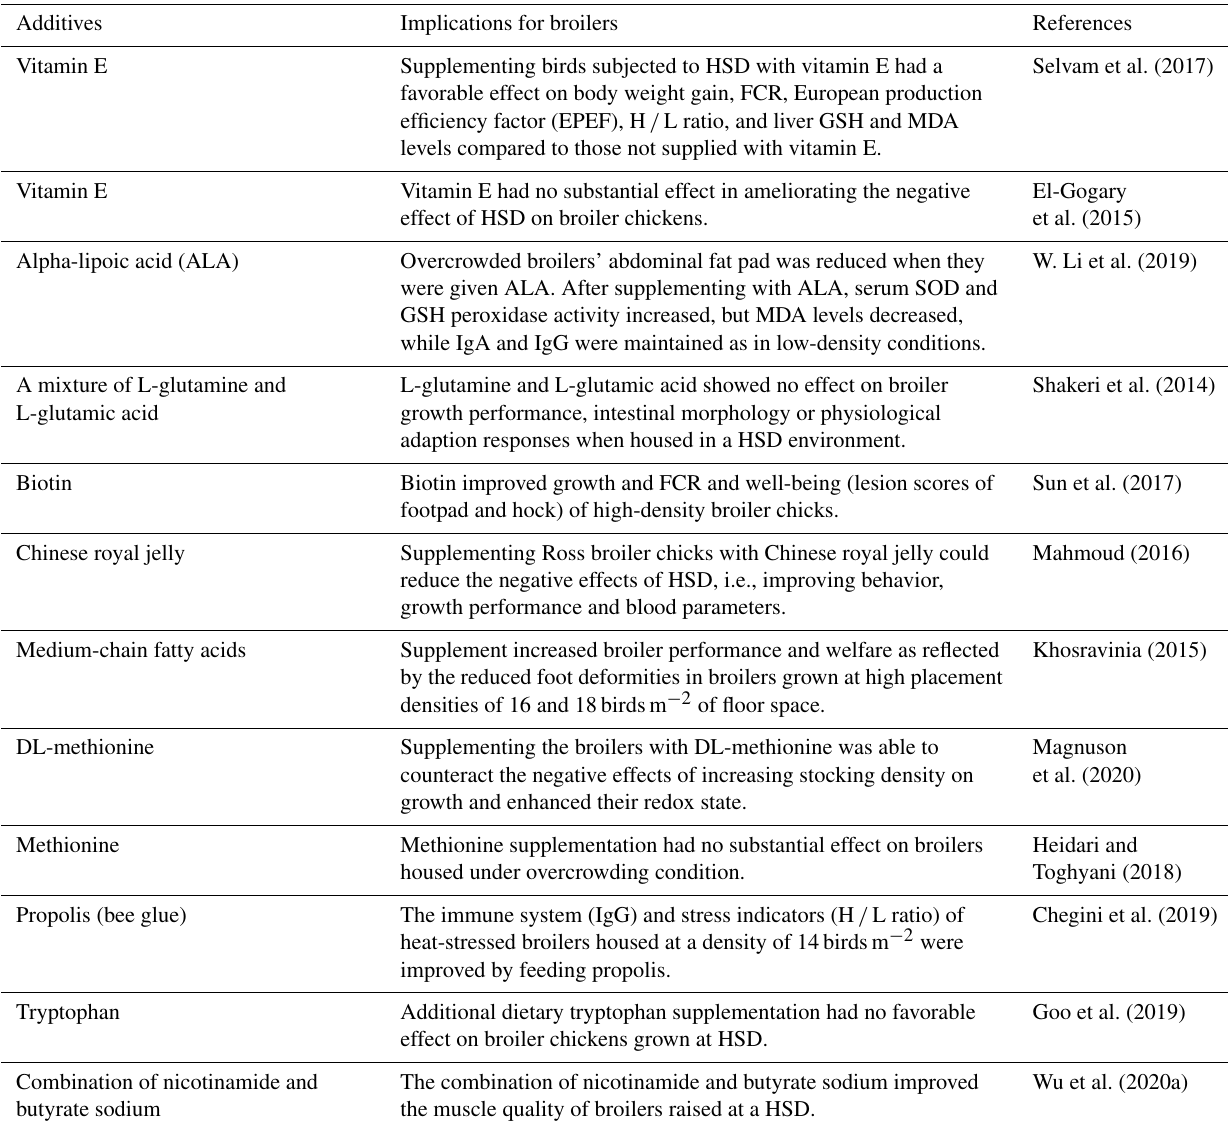
Table 4. Other dietary additives in broilers raised at a high stocking